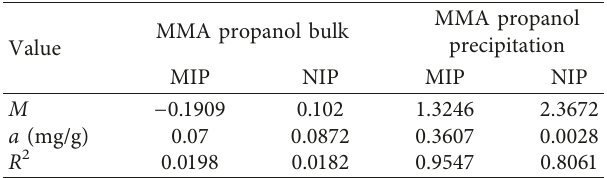
Table 1: Binding capacity MMA propanol bulk and precipitation method ( n � 3).